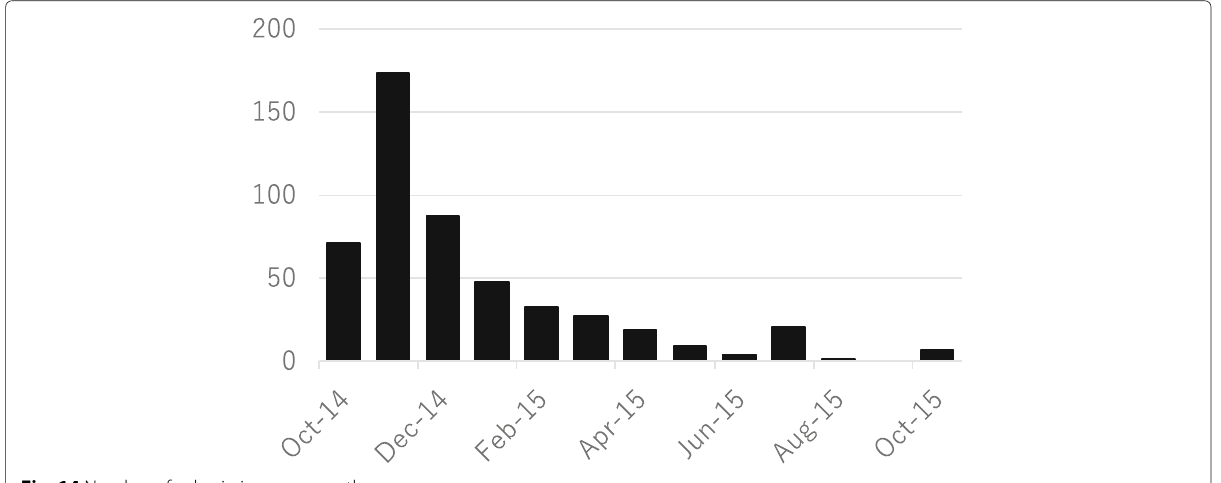
information about Handa City, and the staff of the tourist information office created the content for the dialog